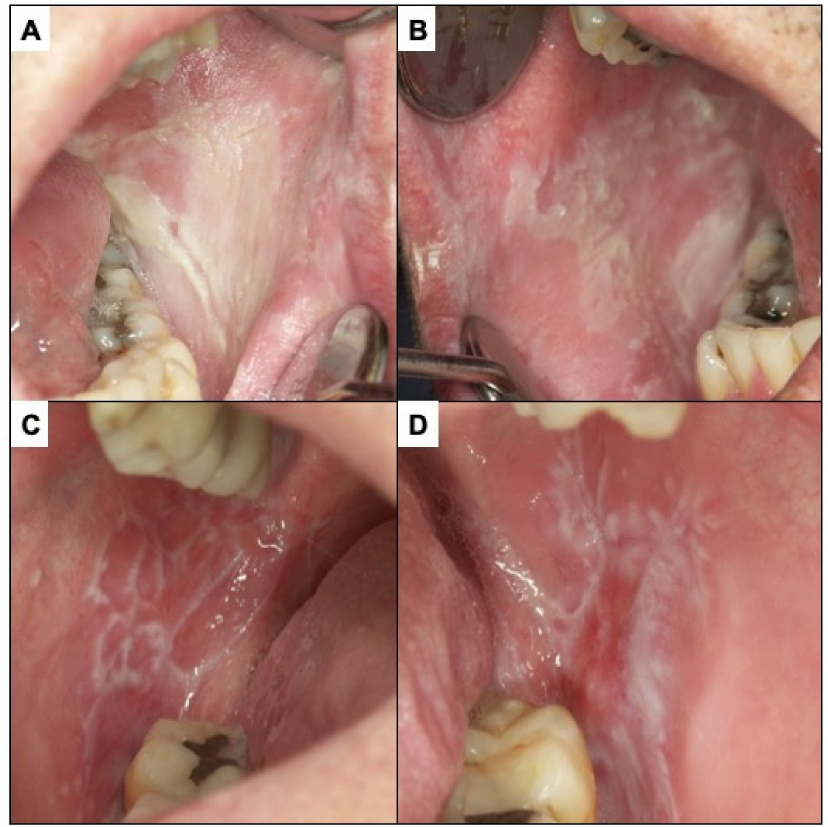
Figure 4. ( A , B ) White spongy nevus. It is a lesion that must be differentiated from PVL. It is a hereditary disease that appears in childhood without premalignant character. ( C , D ) Oral lichen planus. The presence of bilateral white reticular lesions characteristic of this disease should be